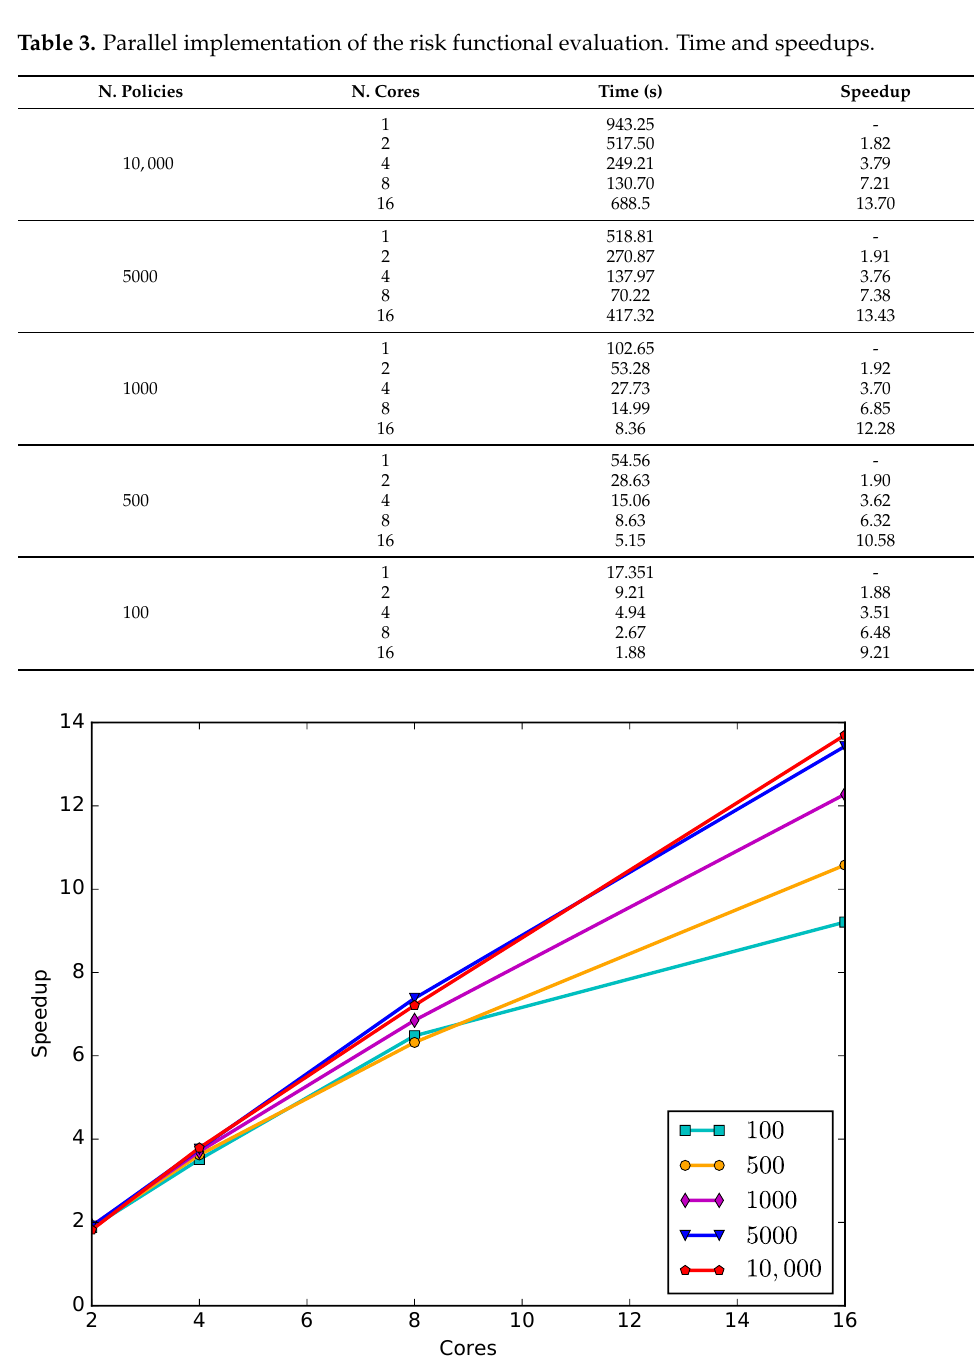
Figure 4. Speedups of parallel implementation vs. number of cores for different numbers of policies in the original